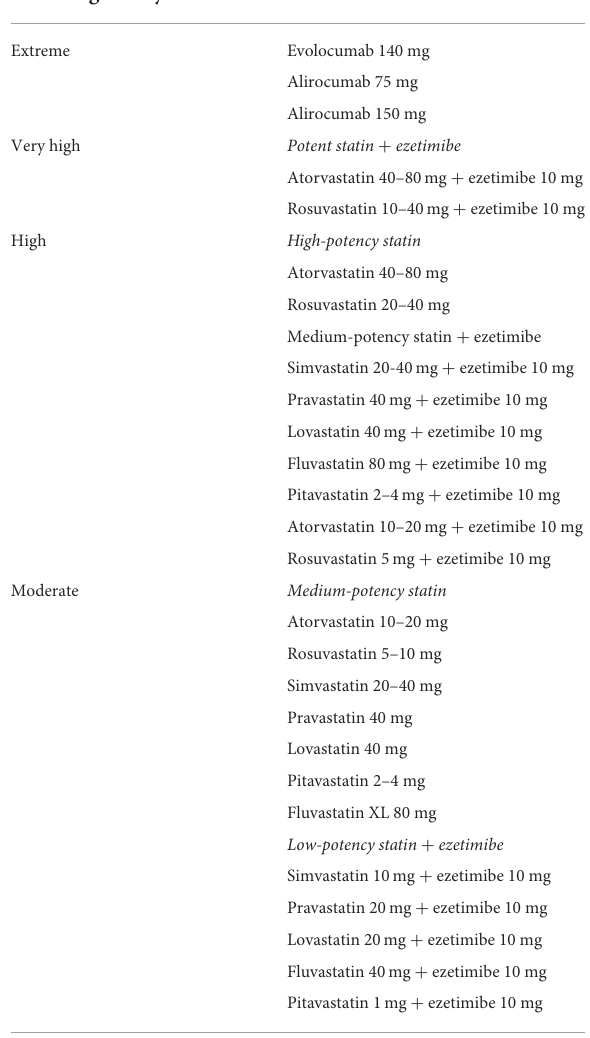
TABLE 2 Diagnoses included for the calculation of the Charlson comorbidity index, and their corresponding ICD-09-CM codes. ICD-09-CM